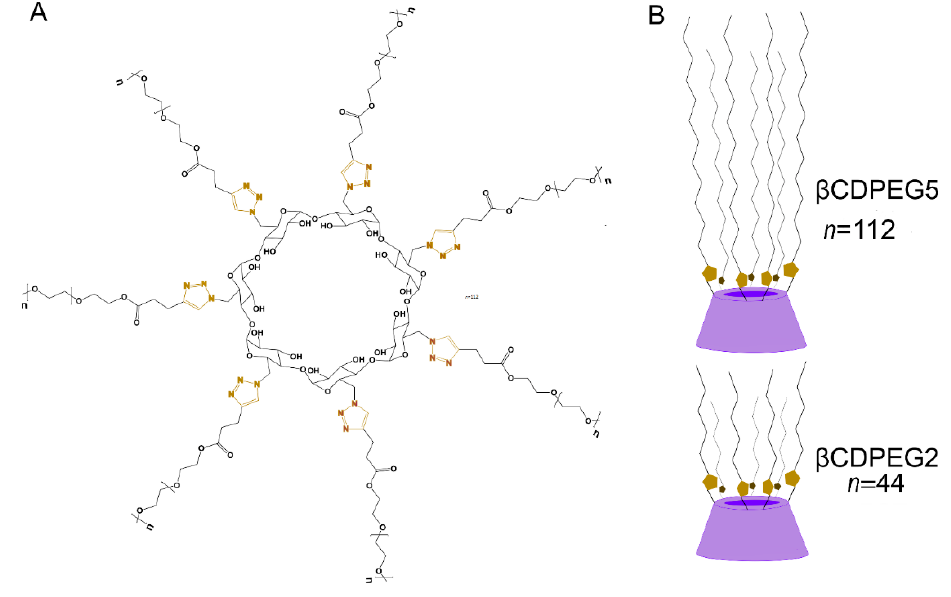
Figure 1. ( A ) Chemical structure and ( B ) schematic representation of β CDPEG5 and β CDPEG2.